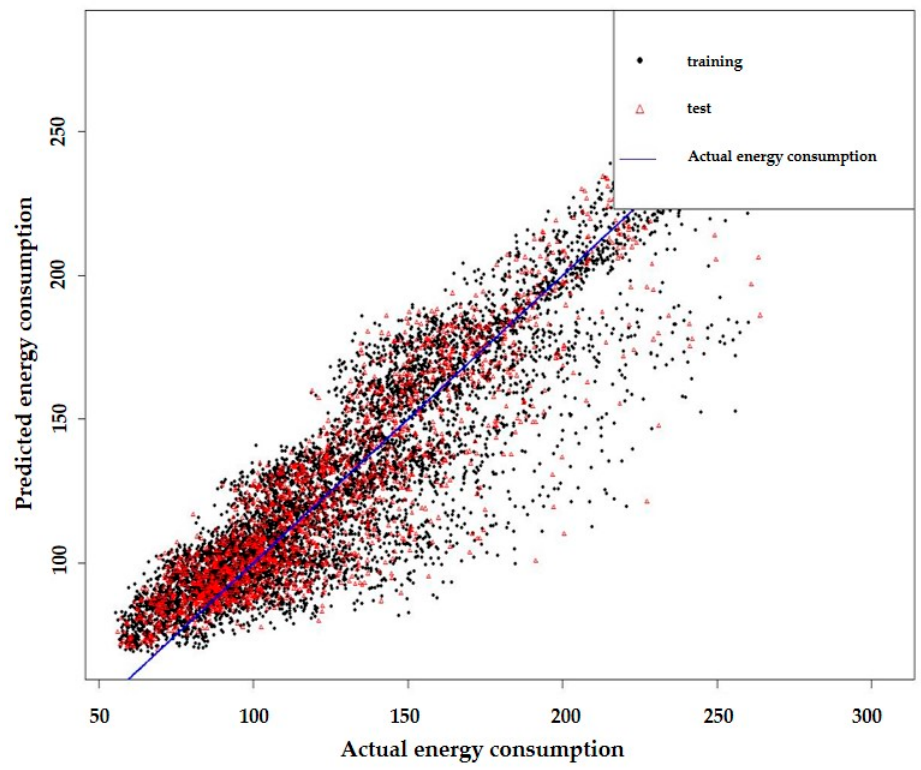
Figure 8. Results of a regression analysis of the 16 original variables.